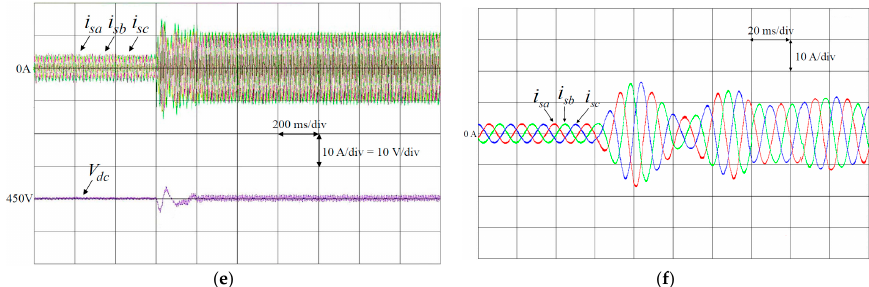
Figure 9. Experimental results at case 1: ( a ) Responses of three-phase currents i sa , i sb , i sc and regulation control of DC-link voltage using PI controlled shunt APF; ( b ) Responses of three-phase currents i sa , i sb , i sc using PI controlled shunt APF in 0.54–0.74 s; ( c ) Responses of three-phase currents i sa , i sb , i sc and regulation control of DC-link voltage using PFNN controlled shunt APF; ( d ) Responses of three-phase currents i sa , i sb , i sc using PFNN controlled shunt APF in 0.54–0.74 s; ( e ) Responses of three-phase currents i sa , i sb , i sc and regulation control of DC-link voltage using proposed PPFNN controlled shunt APF ( f ) Responses of three-phase currents i sa , i sb , i sc using proposed PPFNN controlled shunt APF in 0.54–0.74 s.